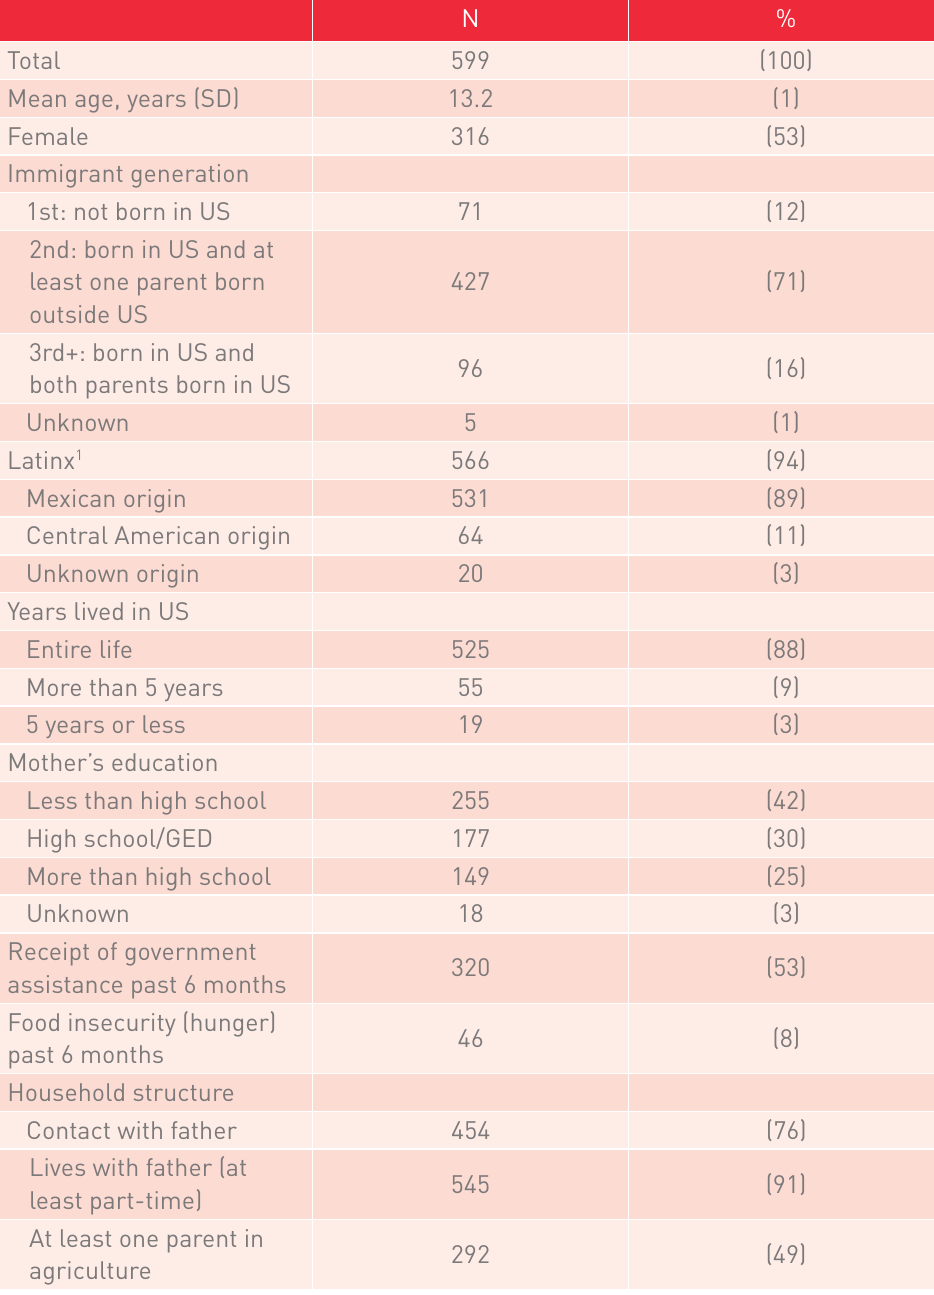
: Salinas Teen A Crecer